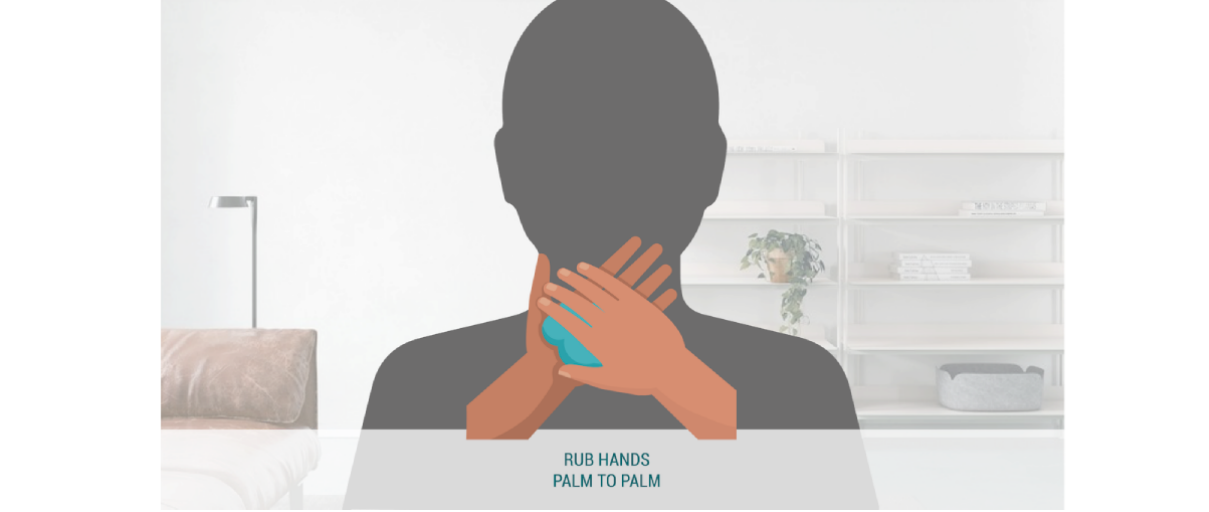
Figure 6. Self-focused augmented reality